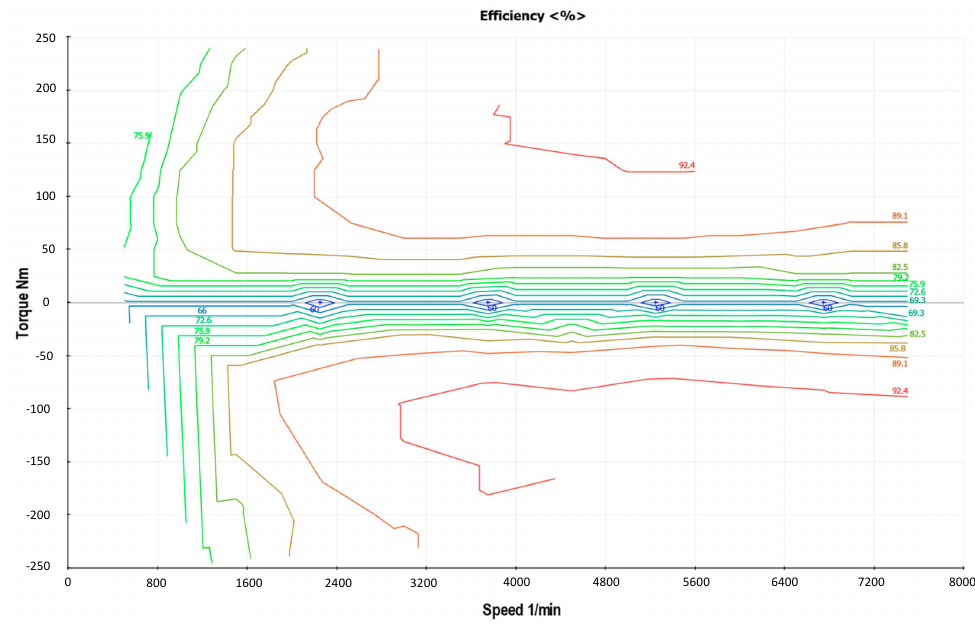
Figure 10. Electric machine efficiency